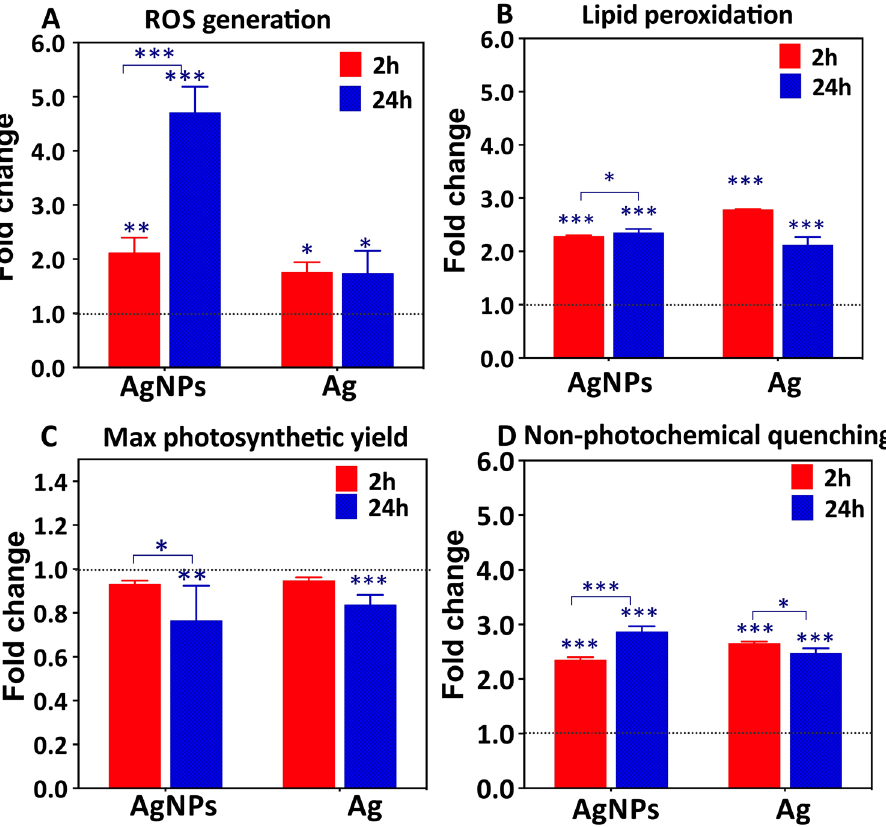
Figure 3. Effect of 1.0 mg L −1 AgNPs or 40.7 μg L −1 AgNO 3 exposure on physiology of P. malhamensis . ( A ) ROS generation, determined by CellRoxGreen stain and FCM; ( B ) lipid peroxidation, assessed by MDA test; ( C ) maximum quantum yield of photosystem II (Fv/Fm); and ( D ) non-photochemical quenching (NPQ). Fold change is calculated as a ratio of the respective effects observed in Ag—treated cells and untreated control. Asterisks indicate a significant difference between treatments obtained by two-way analysis of variance (ANOVA) followed by a Sidak’s multiple comparisons test: * p < 0.05; *** p < 0.01; *** p <